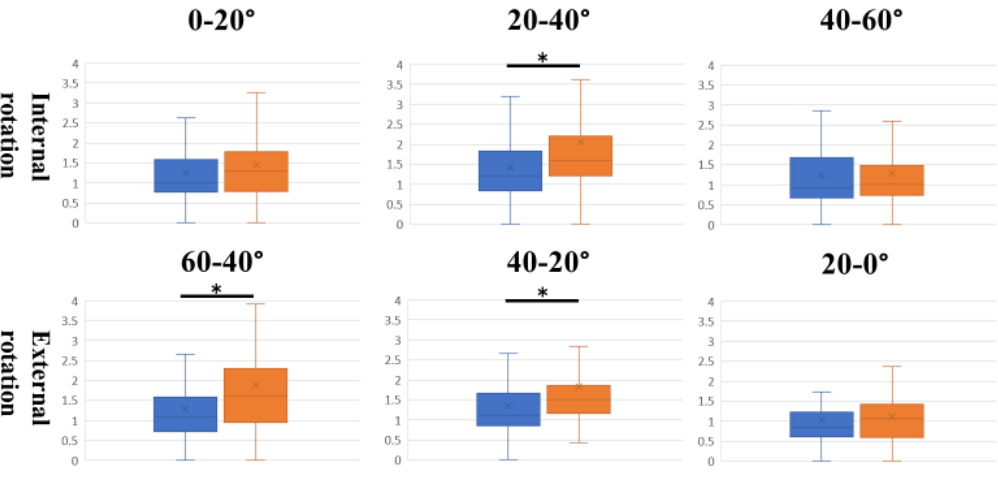
Figure 5. The affected side was significantly slower during internal rotation at 20 to 40 degrees, and the affected side was significantly slower during external rotation at 60 to 40 degrees of internal rotation and 40 to 20 degrees of internal rotation.